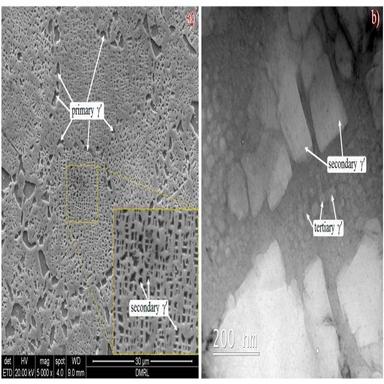
a) SEM micrograph of as-HIPed superalloy revealing primary γ′ and secondary γ′ (highlighted in inset) b) TEM micrograph revealing secondary γ′ and ultrafine tertiary γ′